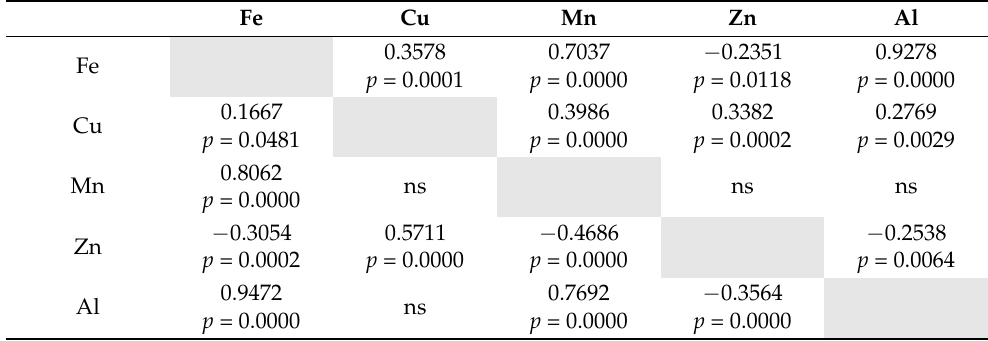
Table 4. Spearman rank correlation coefficient (R s ) and p -value of trace elements in feed and coat.